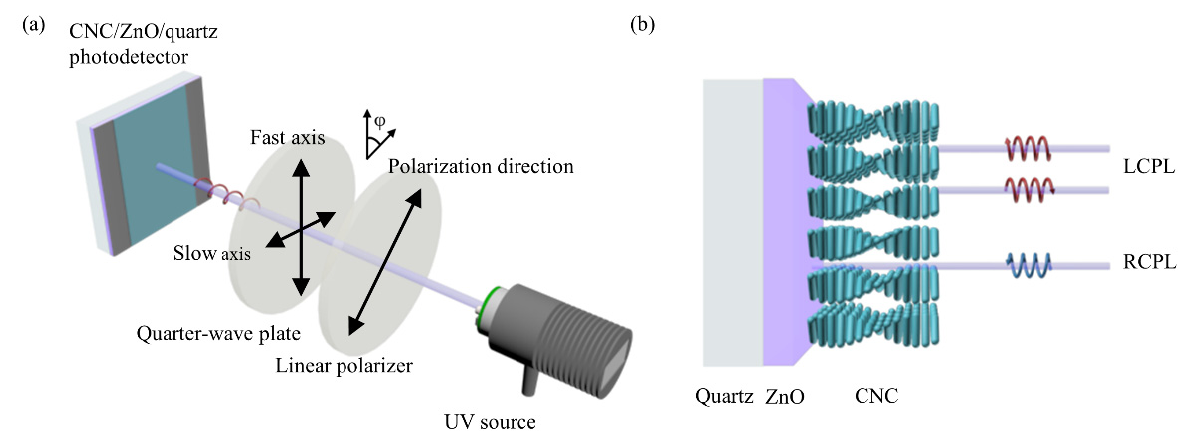
Figure 6. ( a ) Schematic diagram of the generation and detection of CPL. ( b ) Schematic diagram of the optical path with CNC/ZnO photodetector under the illumination of LCPL and RCPL respectively.